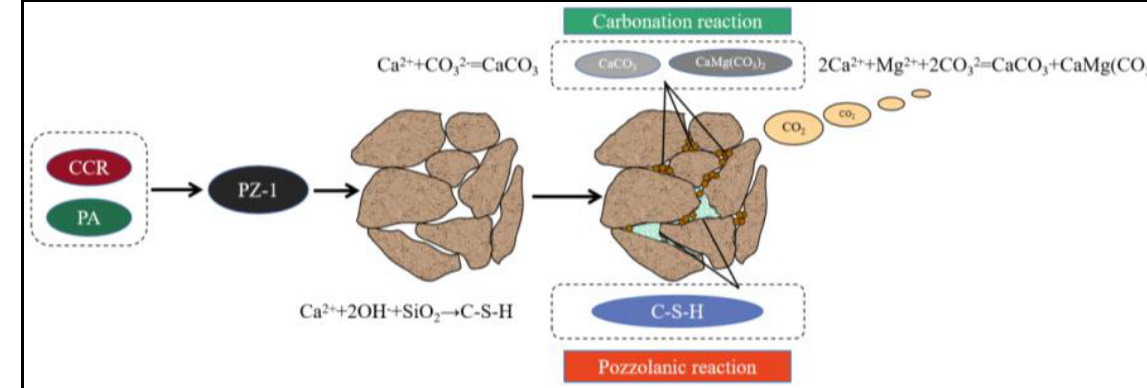
Figure 20. Stabilized mechanism of the waste silt with PZ–1 curing agent.